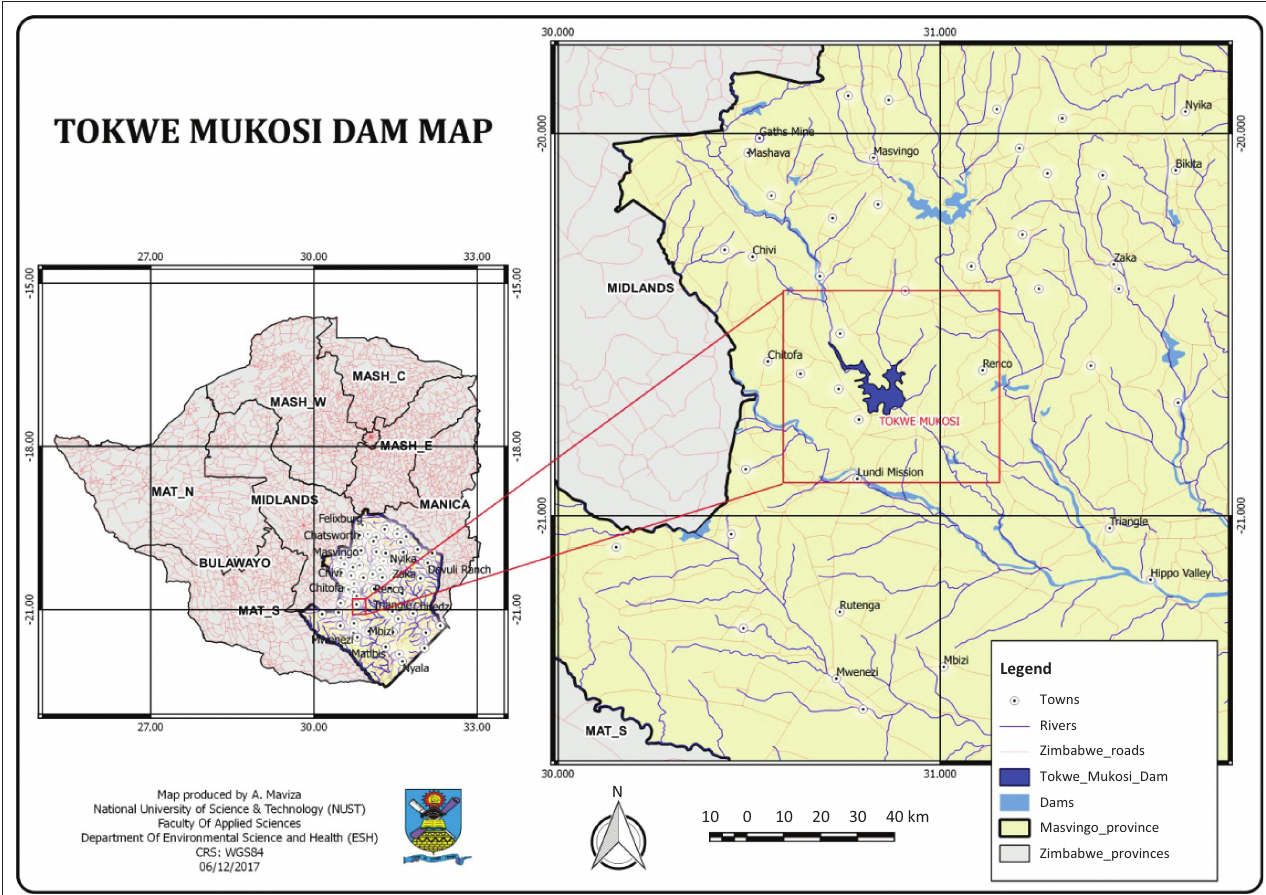
FIG URE 1: Location of Tokwe-Mukosi